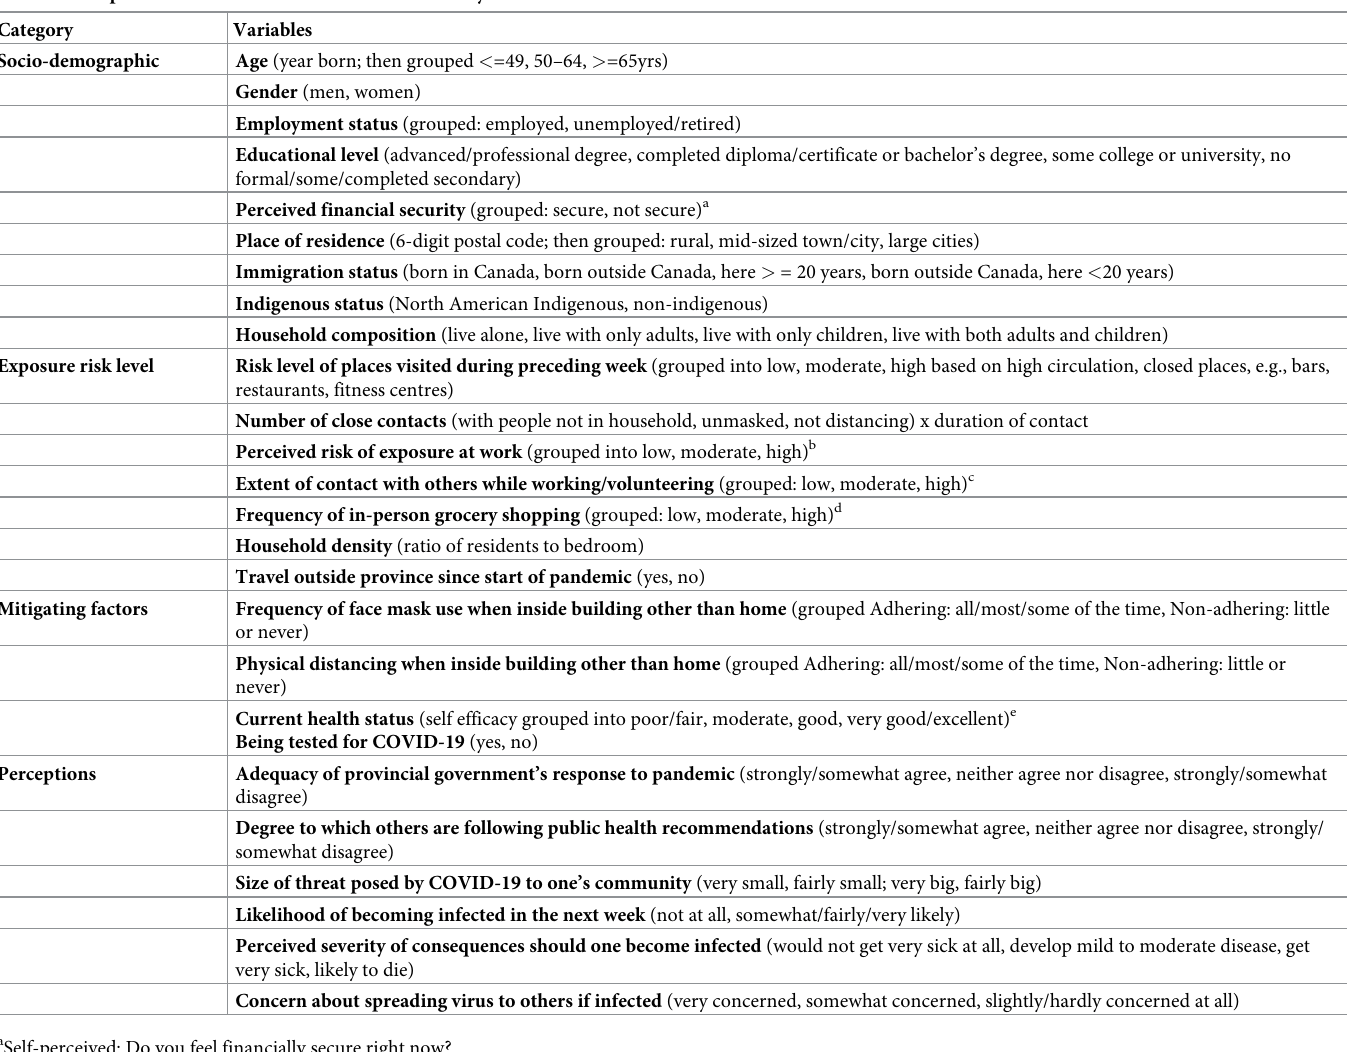
Table 1. Independent variables included in statistical